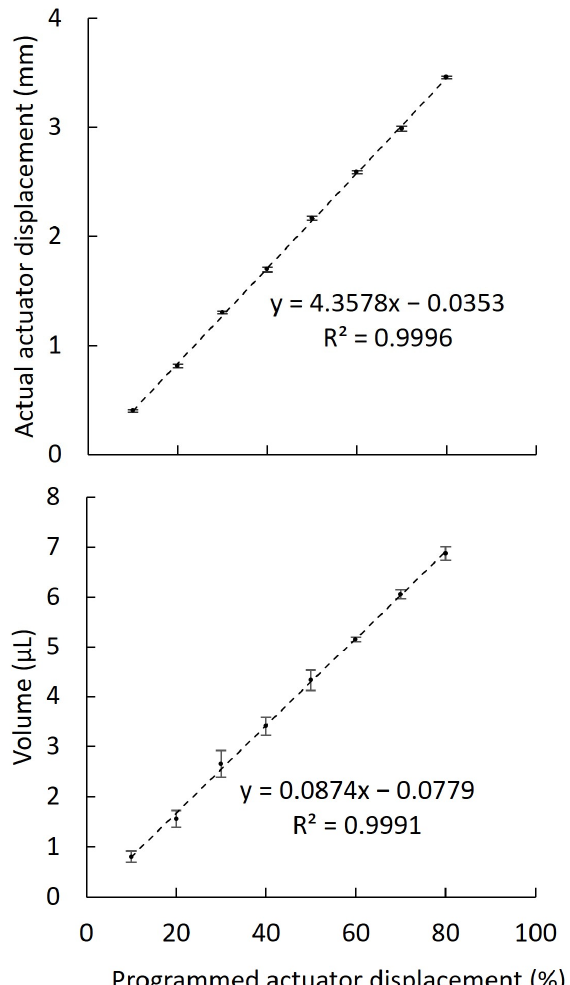
Figure 3. Characterization of a low-cost linear actuator for volume control with the standardized artificial insemination device (SAID). There were linear relationships between the programmed and actual positions of the linear actuator ( upper panel ) and between the programmed position and volume of sample transfer ( lower panel ).